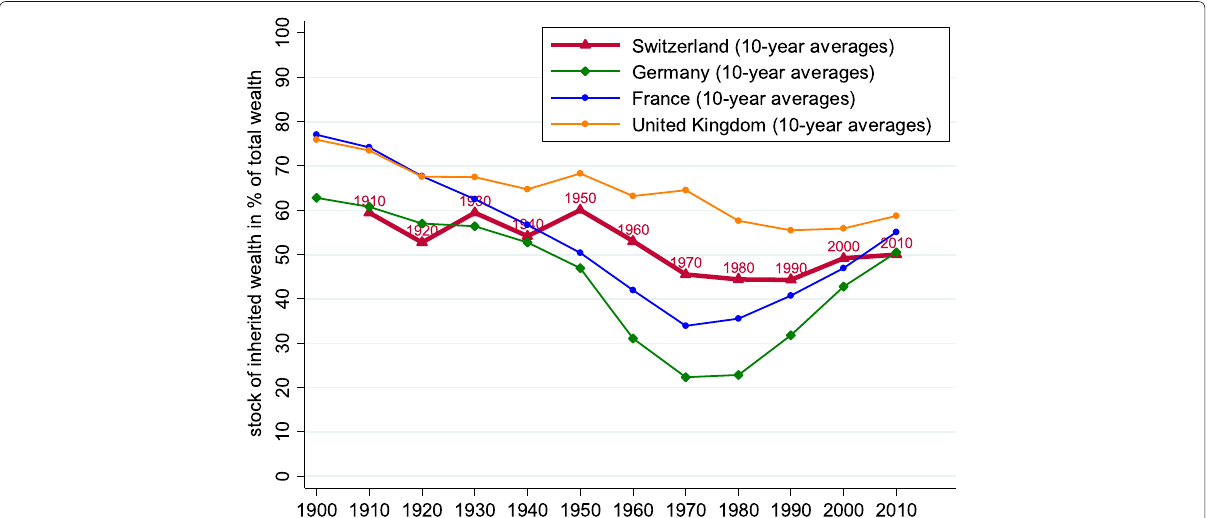
Fig. 7 Cumulative stock of inheritances as a fraction of private wealth. Notes: data points are 30-year moving averages, reported every 10 years. See text for Swiss data sources. Data for France and Germany from Alvaredo et al. (2017), data for the United Kingdom are from Atkinson (2013)